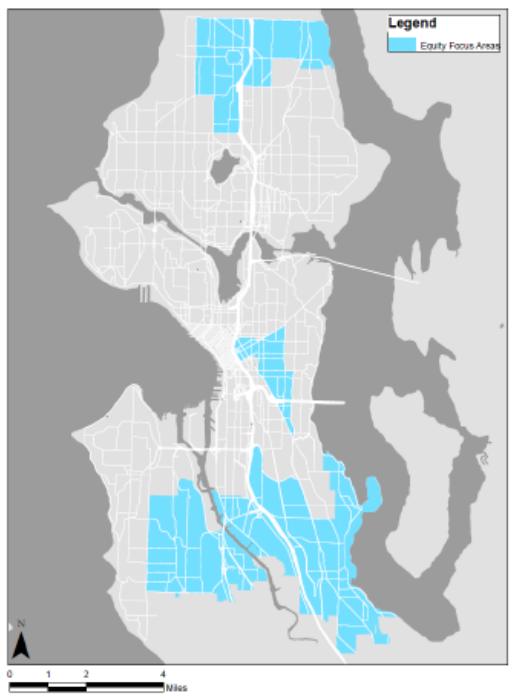
Figure 2. Map highlighting ‘Equity focus areas’ in which vendors must distribute 10% of their fleet. Source: Seattle Department of Transportation